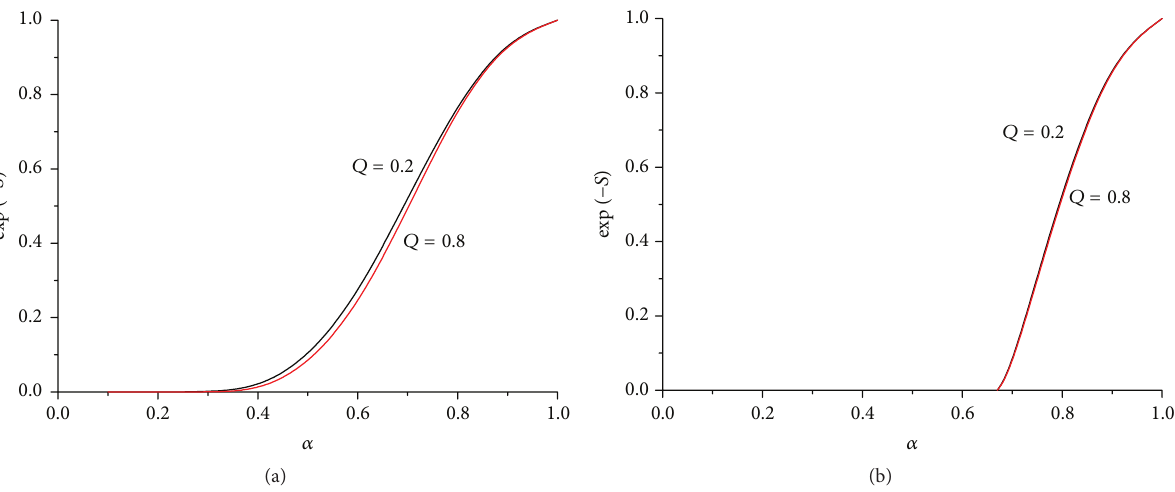
Figure 4: 𝑒 −𝑆 versus 𝛼 with fixed 𝑧 0 /𝑧 𝑡 . (a) 𝑧 0 /𝑧 𝑡 = 0.1 . (b) 𝑧 0 /𝑧 𝑡 = 0.8 . In all plots from top to bottom 𝑄 = 0.2, 0.8